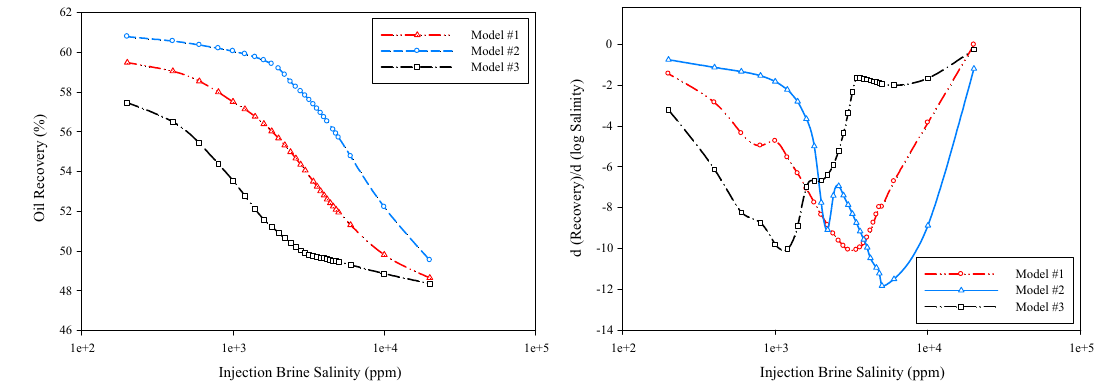
Fig. 15 Effect of injection brine salinity on the oil recovery (left side) and its derivative regarding injection brine salinity (right side) in various salinity threshold ranges